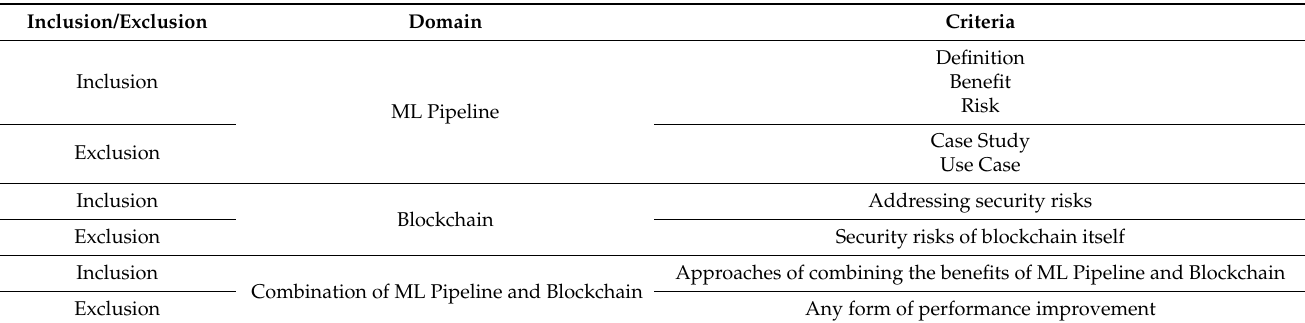
Table 1. Inclusion/Exclusion Criteria.